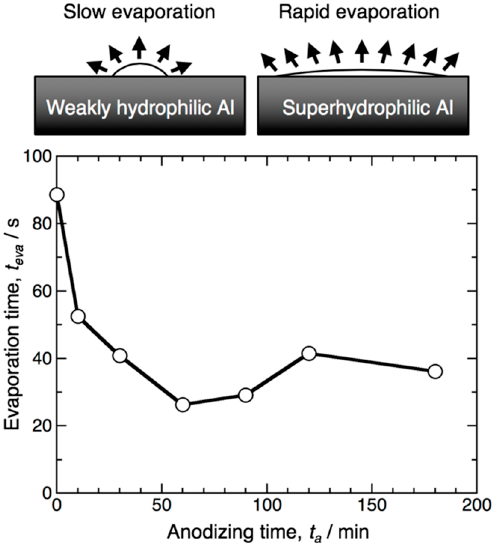
Figure 2. Change in the evaporation time of a 0.5 µ L water droplet, t eva , with the anodizing time, t a , on the aluminum specimen anodized at 283 K and 80 V. The temperature of the aluminum substrate was maintained at 313 K using a thermoelectric Peltier module.